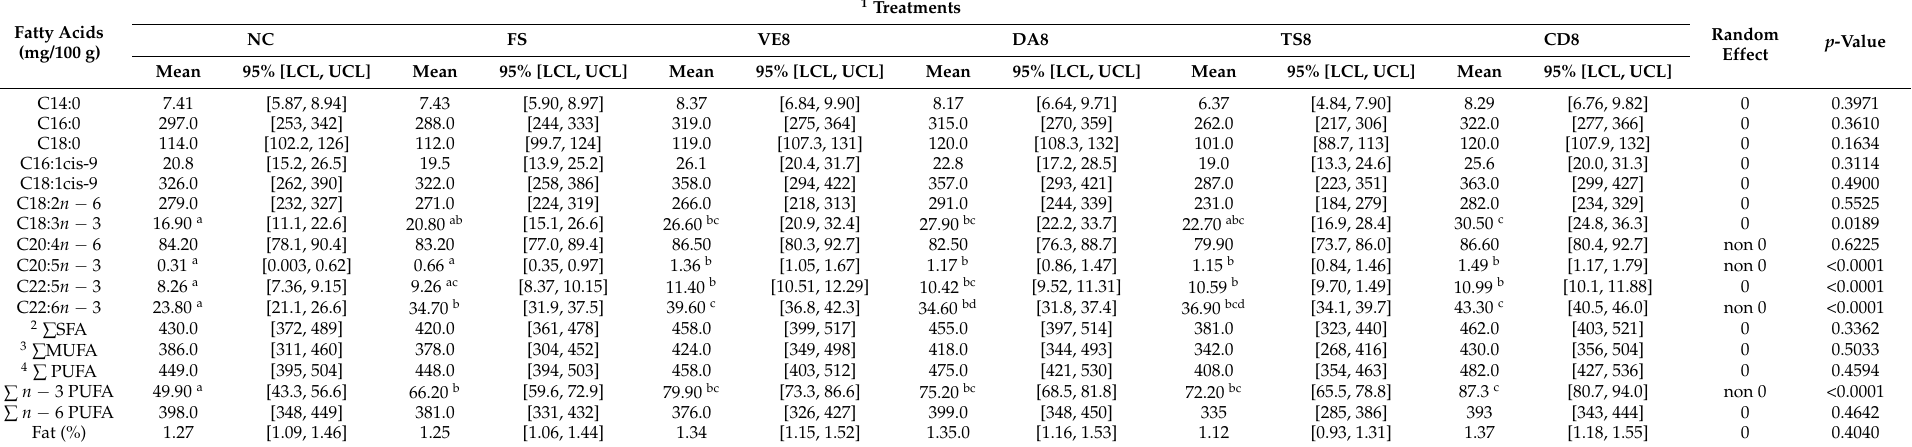
Table 3. Effect of supplementing plant polyphenol extracts and flaxseed on fat content and fatty acid concentration (mg/100 g) in raw breast muscle of Sasso